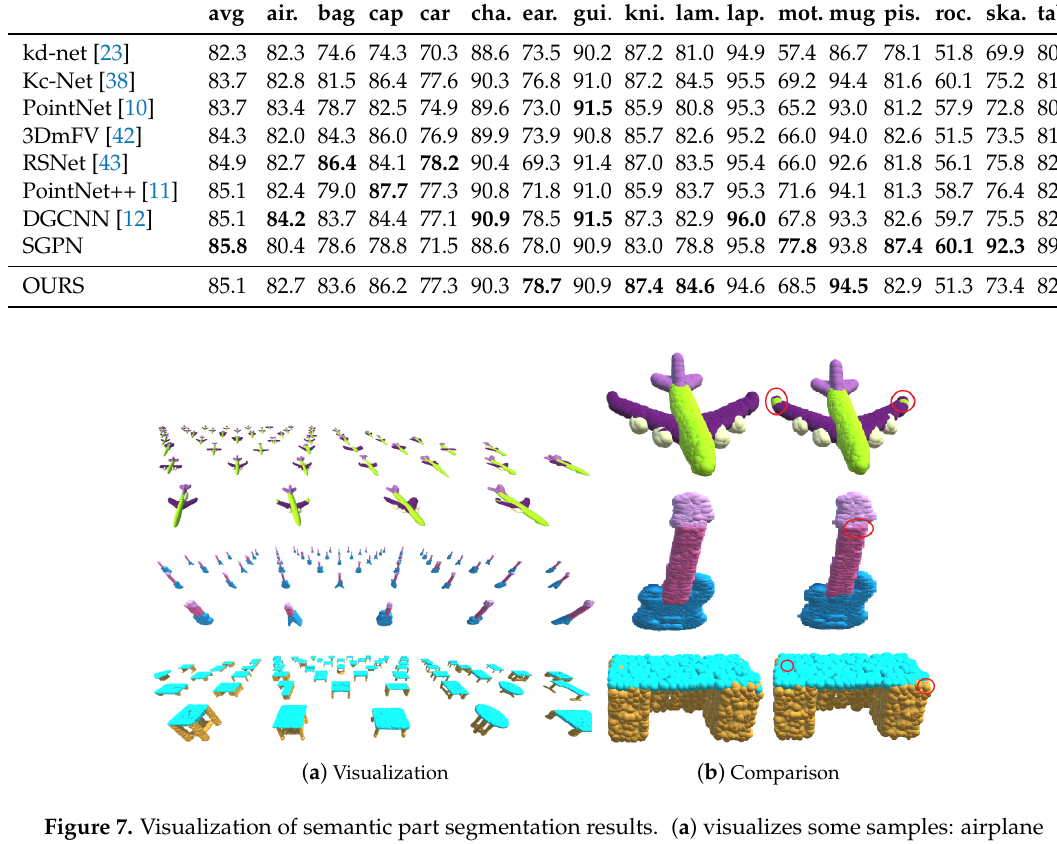
Figure 7. Visualization of semantic part segmentation results. ( a ) visualizes some samples: airplane (top), guitar (middle), and table (bottom), while ( b ) visualizes the predictions and corresponding errors (right) compared to ground truth (left).